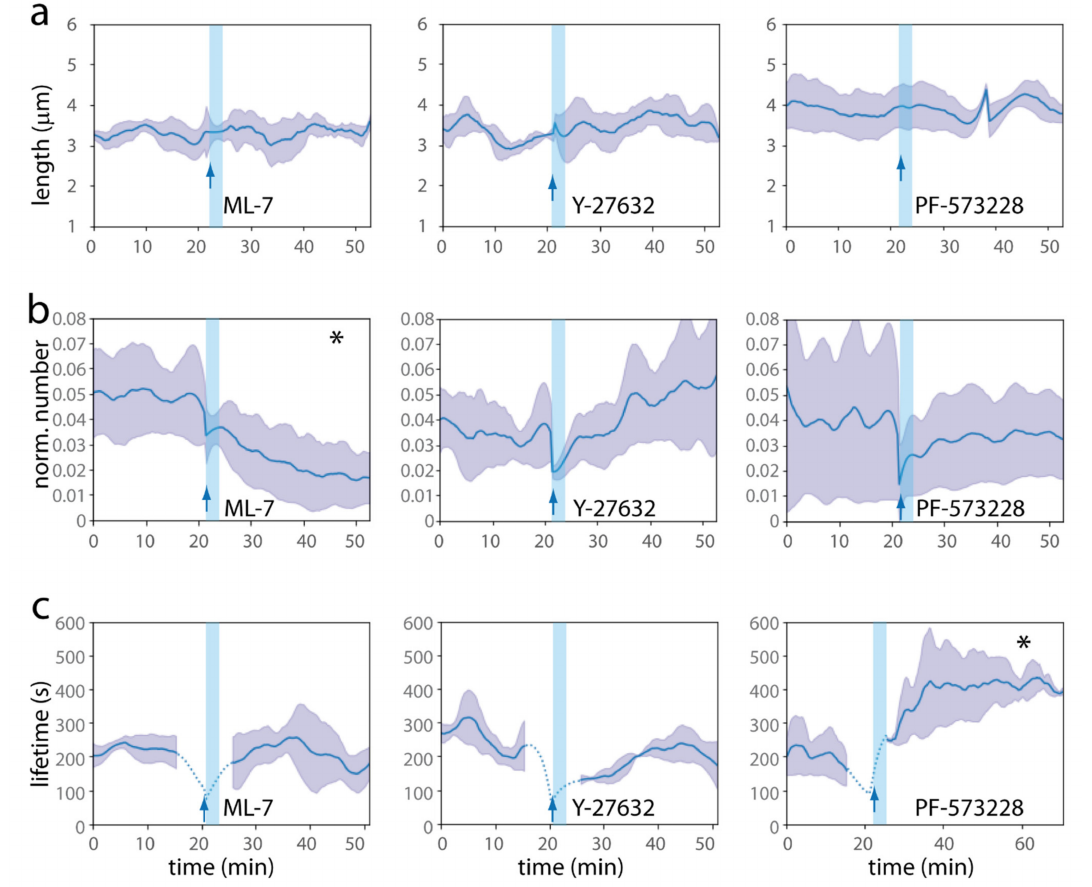
Figure 8. Quantitative analysis of ML-7, Y-27632 and PF-573228 effect on filopodia dynamics. ( a – c ) Evolution along time of ( a ) mean filopodia lengths, ( b ) normalized number of filopodia (nor- malization by the perimeter, in µ m, of the cell islets inside the structure), and ( c ) mean lifetimes of filopodia present at this time, for ML-7 (left), Y-27632 (middle) and PF-573228 (right) treatments, n = 3 independent experiments per condition. Error: S.D. Pre-treatment and post-treatment graphs are concatenated. The blue arrow indicates the time of drug addition. The light blue vertical bar indicates a state of stabilization of the system after media change (~3 min long). The dotted lines for lifetime ( c ) refer to times where the lifetime cannot be precisely assessed, because of the imaging interruption during media changes (durations, ~1 mean filopodia lifetime before and after drug addition; see Materials and Methods). * in ( b ) ML7, and ( c ) PF-573228, indicates statistically significant differences before and after drug addition, with p < 0.05 (see Figure